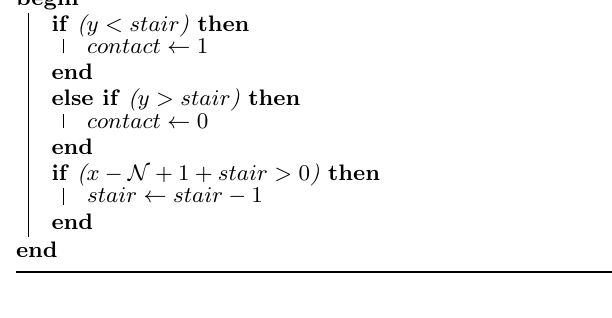
Figure 4: Division and in- terdependence of different subsystems. Arrows show information flow. Square element shows discrete component while circular show